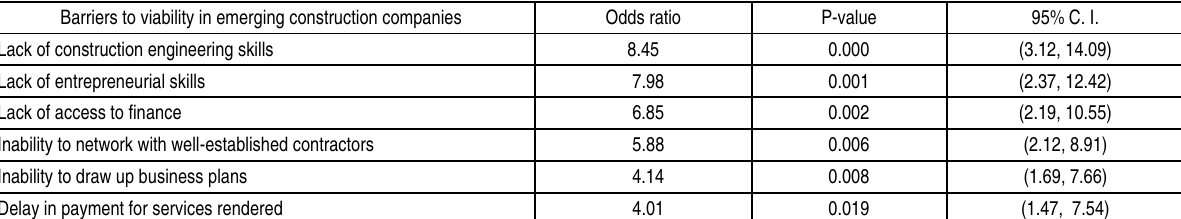
Table 5. Factors that affect viability in emerging construction